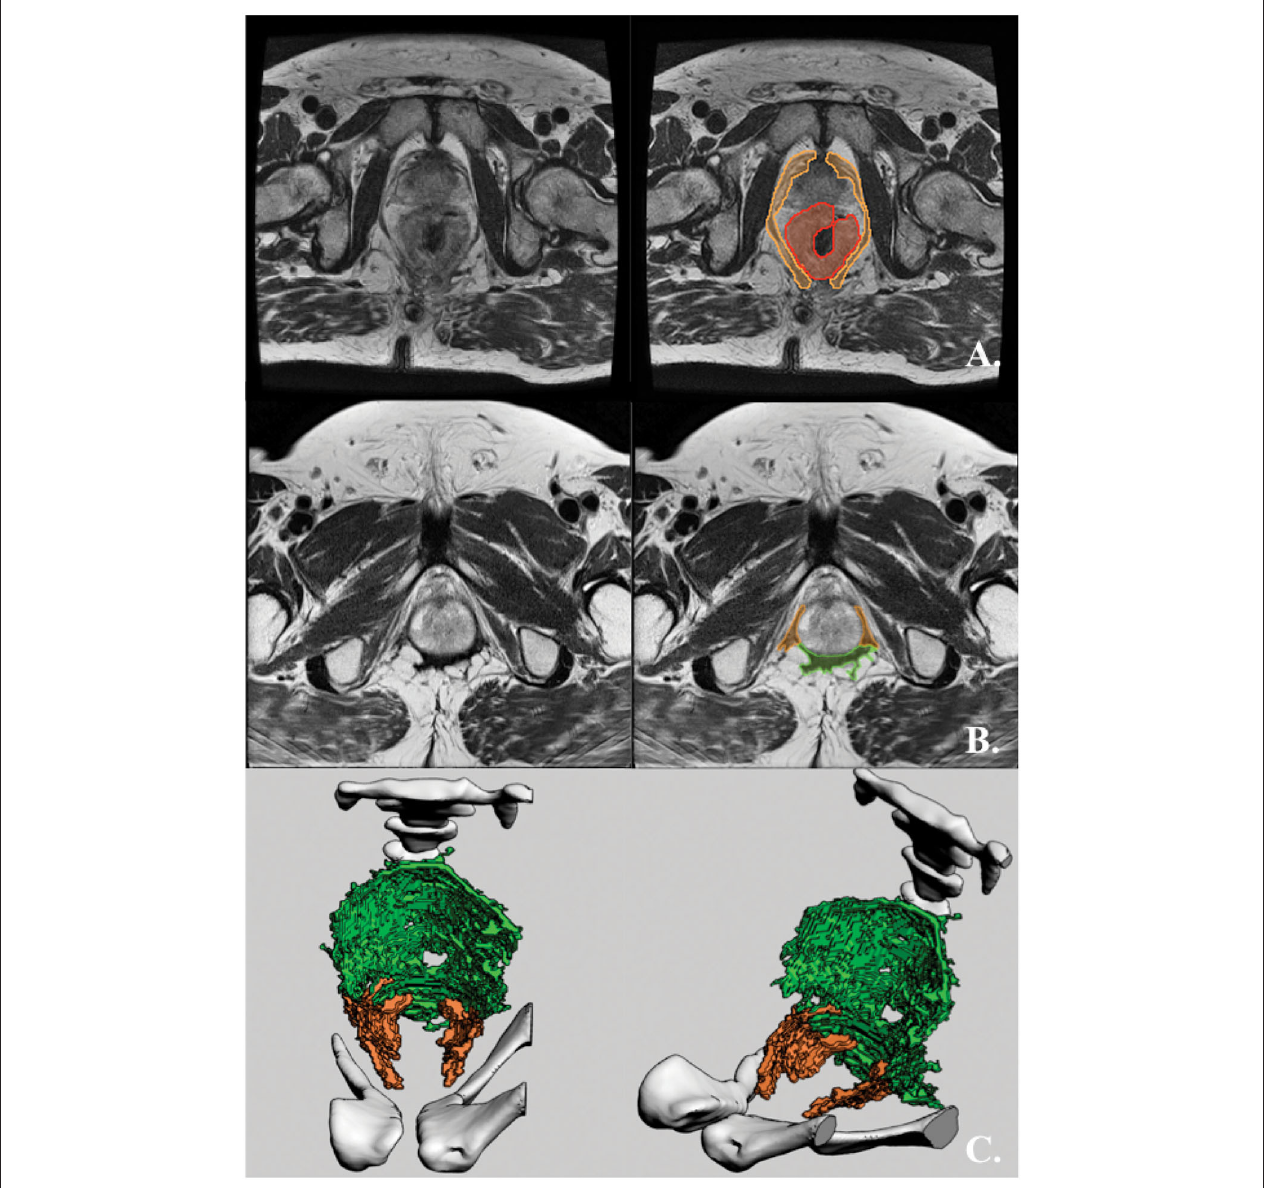
FIGURE 6 | ELAPE without RPD in the posterior quadrants. (A) Preoperative axial T2-weighted MRI of a rectal cancer patient with an mrT3 tumor with circumferential growth (from 1 o’clock to 1 o’clock) and invasive growth from 3 o’clock to 8 o’clock. RPD is hatched in orange, while the tumor is hatched in red. (B) Postoperative axial T2-weighted MRI of the same patient. RPD hatched in orange while supporting mesh hatched in green. (C) The pelvic diaphragm of the same patient, 3D-rendered and shown in superior and antero-lateral superior views. The rendering is made from the above postoperative MRI. The bony pelvis is rendered in white, RPD is rendered in orange, and supporting mesh is rendered in bright